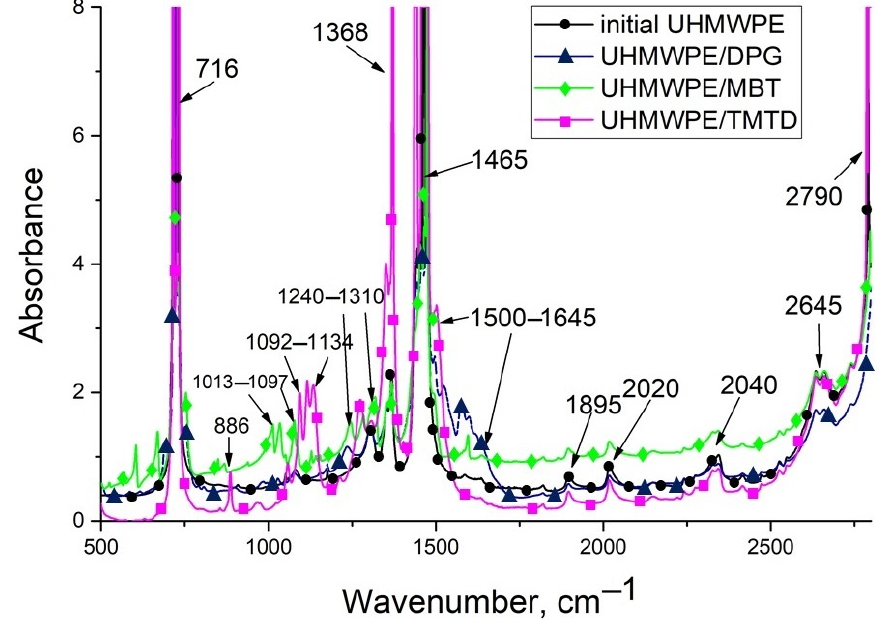
Figure 4. FTIR spectra of PCM based on UHMWPE.